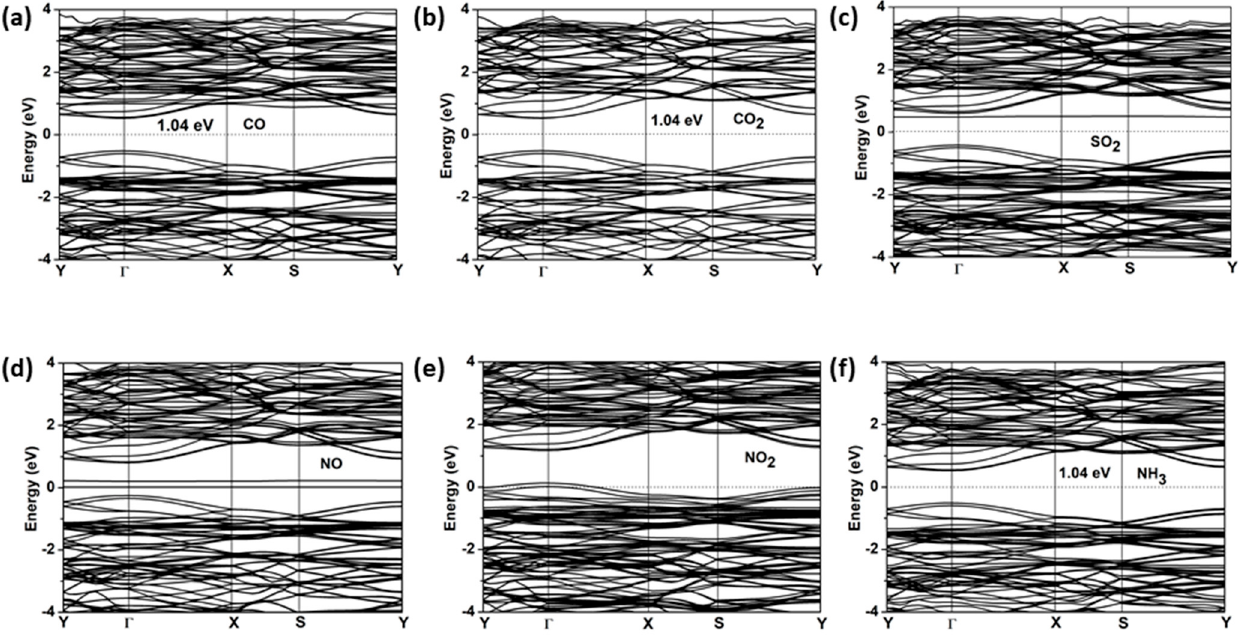
Figure 10. The electronic band structures (PBE functional) for the stable structures of: ( a ) CO, ( b ) CO 2 , ( c ) SO 2 , ( d ) NO, ( e ) NO 2 , and ( f ) NH 3 adsorbed on the ZnSiP 2 monolayer.